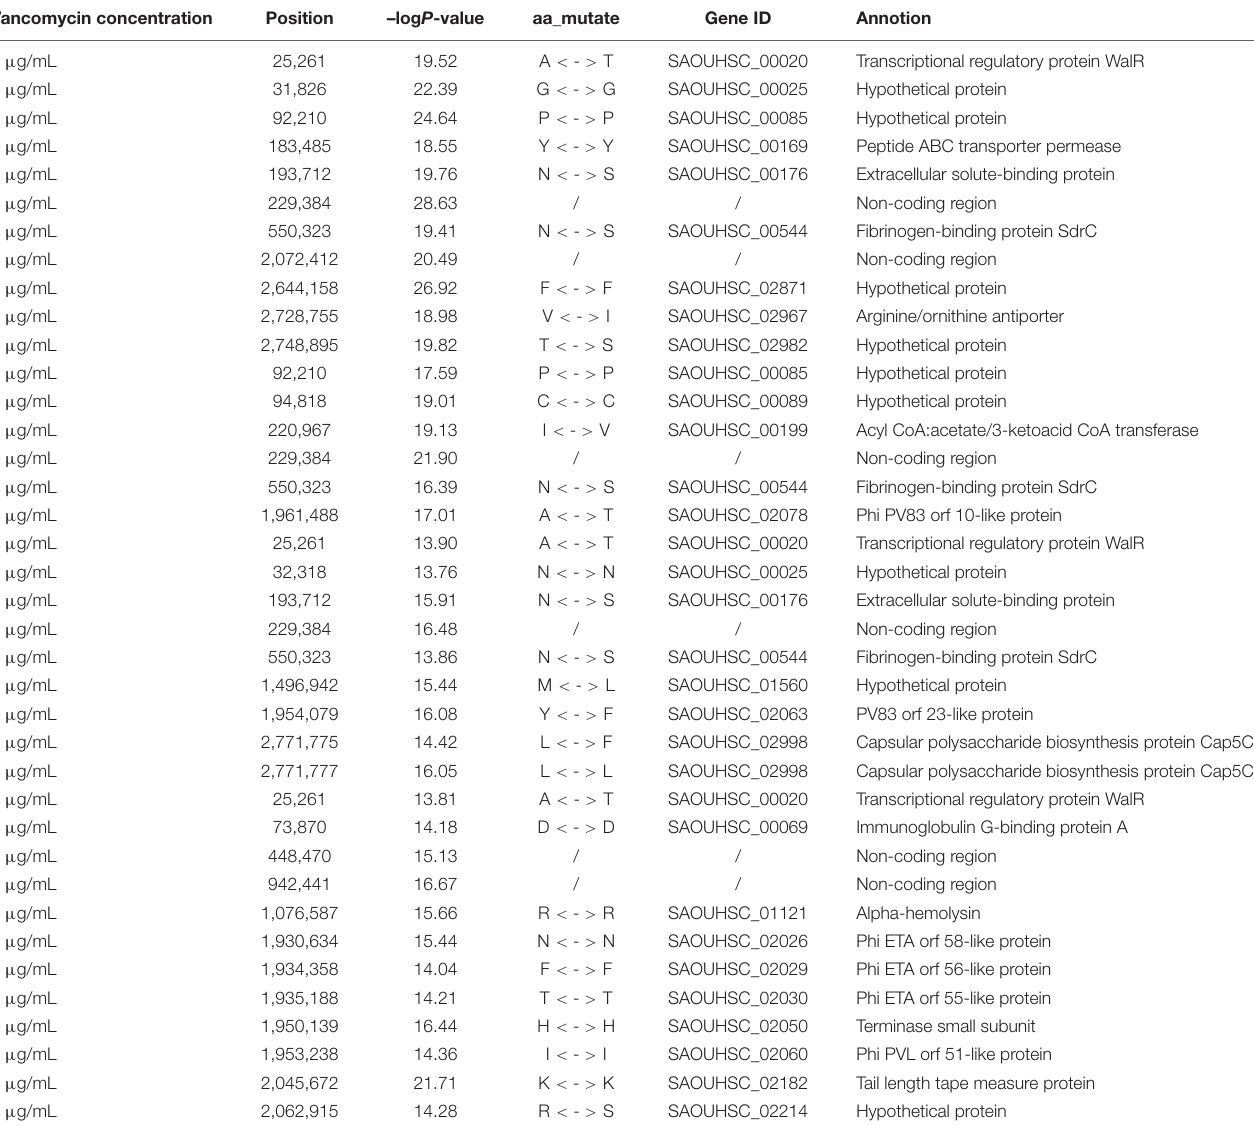
TABLE 1 | Gene annotation of significant sites in functional mapping. Vancomycin